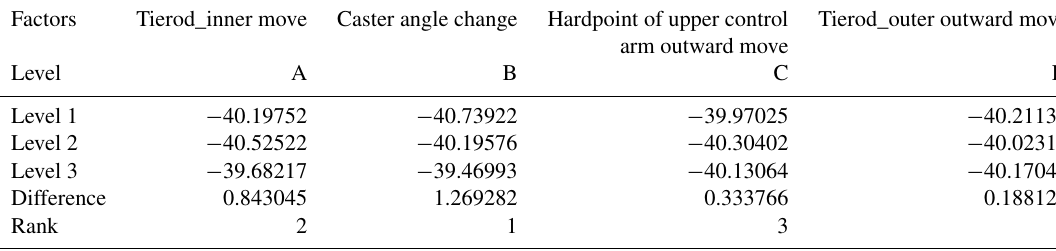
Table 13. SN ratio of the second parameter combination for the Taguchi experiment (steering torque).